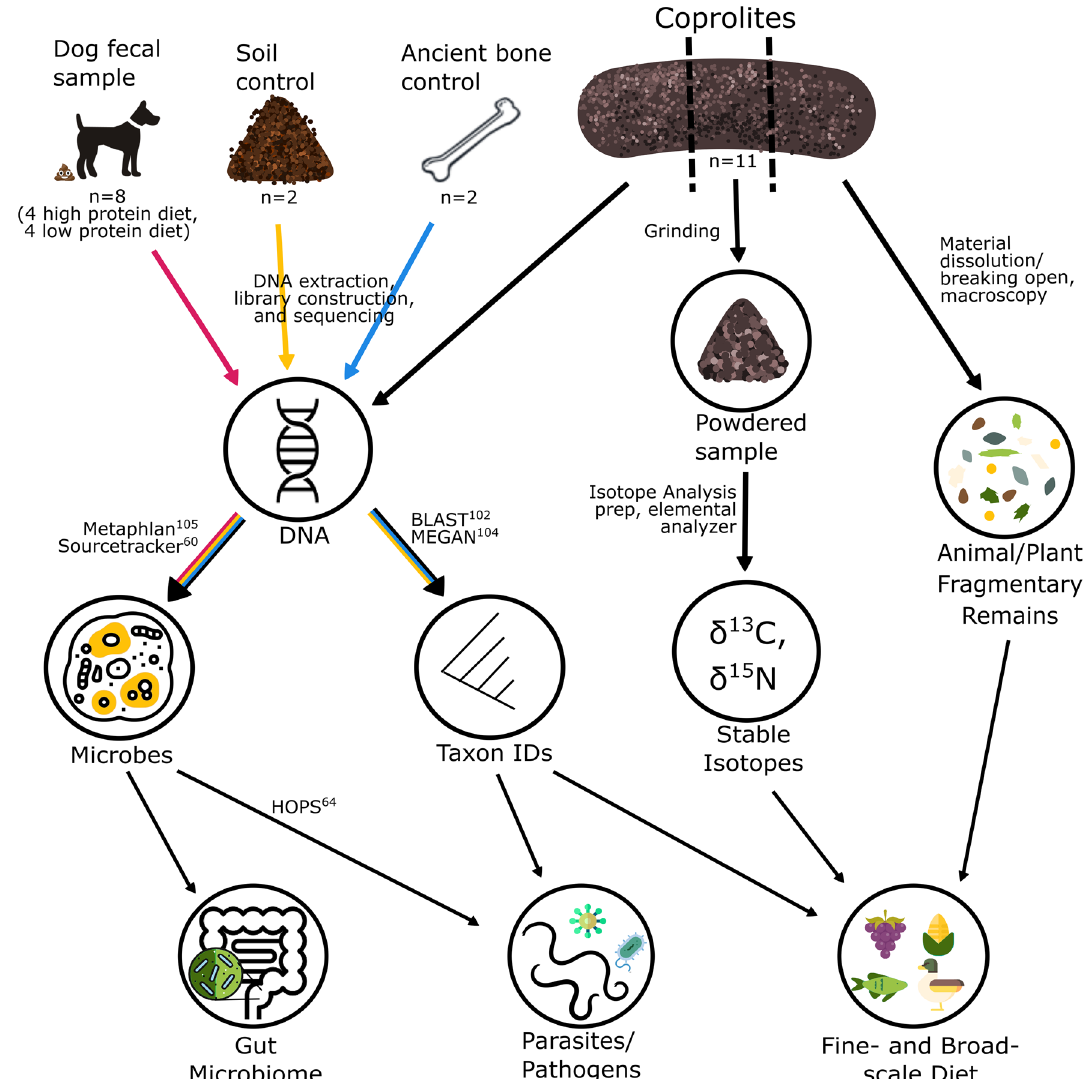
Figure 1. A graphic illustration of our pipeline for inferring diet and microbiome from modern dog feces and archaeological coprolites. The sample size for the coprolites and the controls are indicated underneath each sample type. Controls have color-coded arrows to indicate which controls were used for which analysis method. Arrows are labeled with the methods used to process the sample or analyze the results, and the reference is provided for the software mentioned on the graphic. Note that while macroscopic analysis of coprolites can provide evidence for parasites, in our case we did not identify any using that